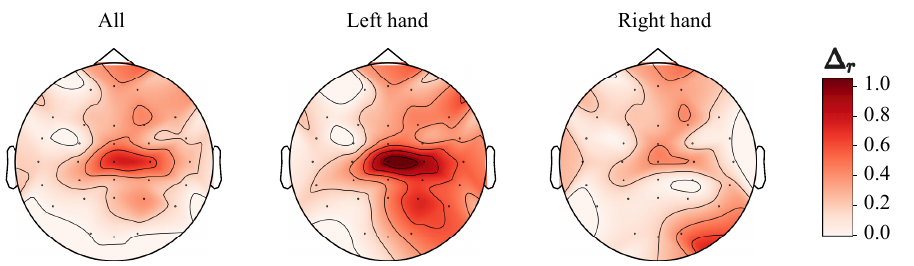
Figure 7. Differences between the r values for elderly and young adults depending on the electrode position